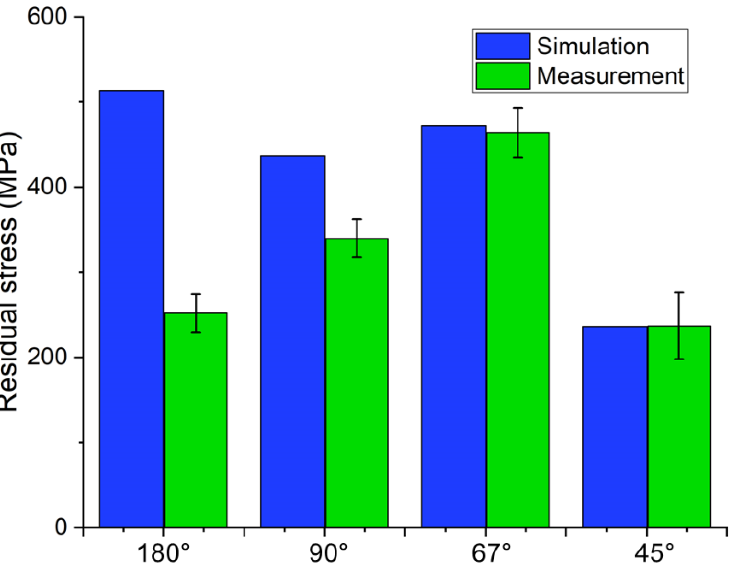
Figure 11. Residual stress comparison between simulation and